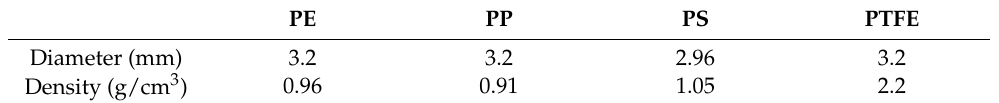
Table 1. The density and diameter of the microplastic beads used in the experiment. PE PP Diameter